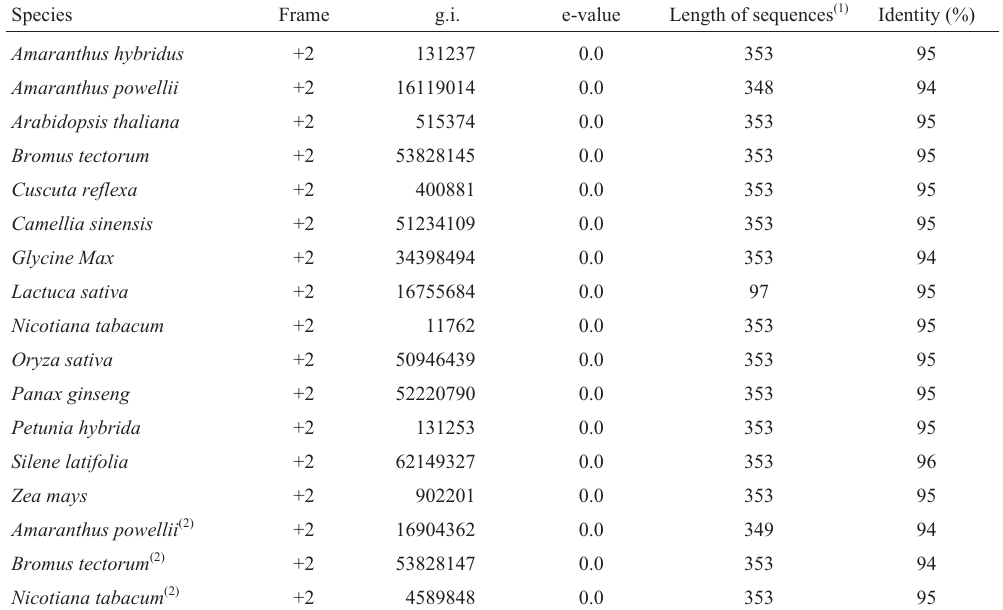
(1) Number of coded amino acids. (2) Resistant to photosystem II inhibiting